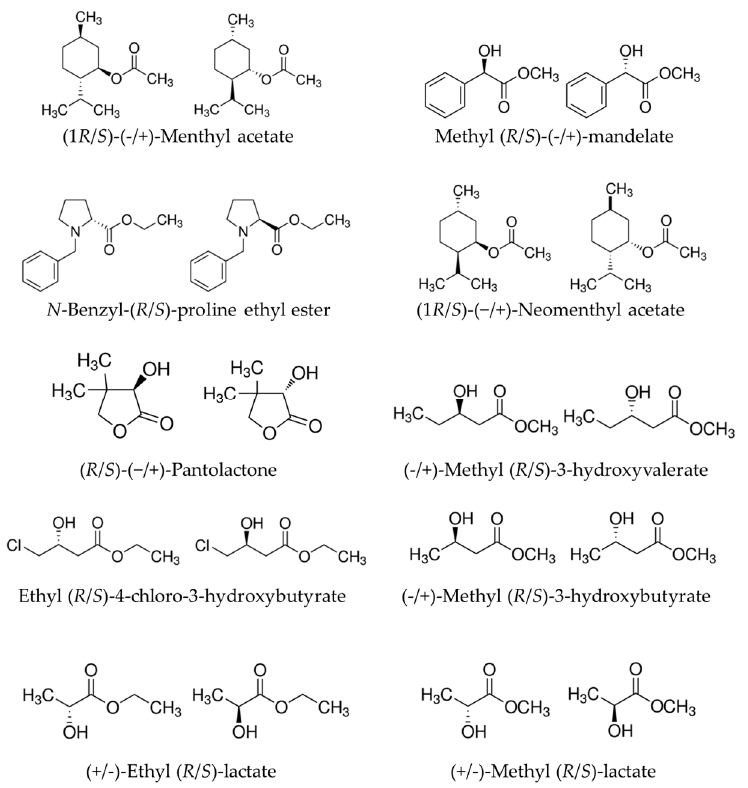
Figure 1. Representative chemical structures of 20 chiral esters used to evaluate chiral selectivity.